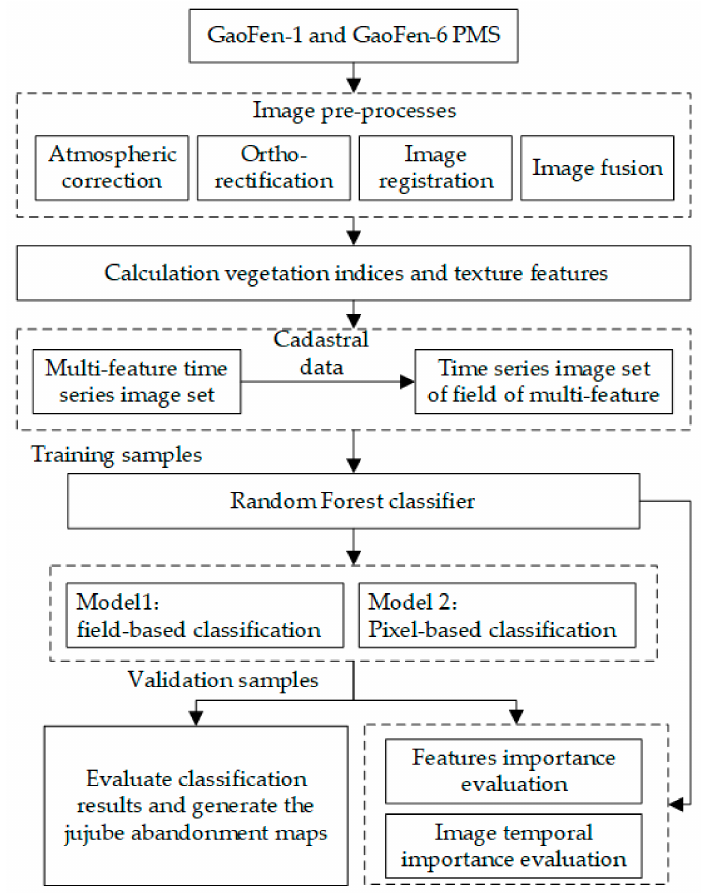
Figure 3. Flowchart of image processing.